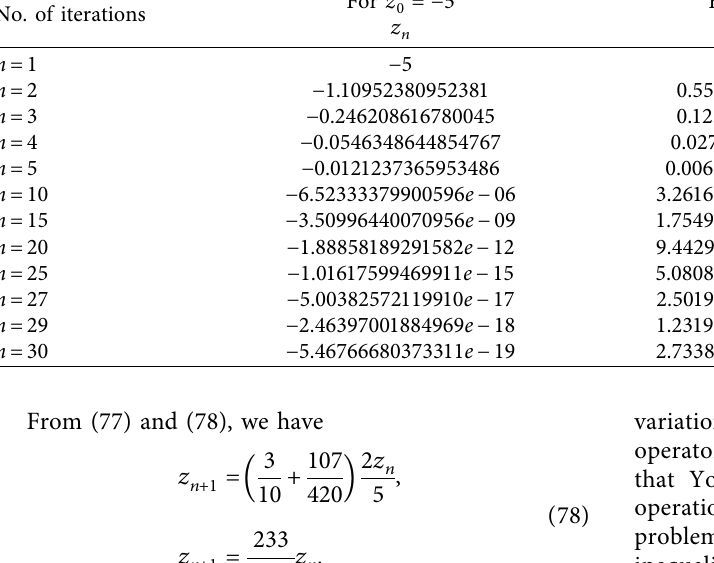
n with initial values